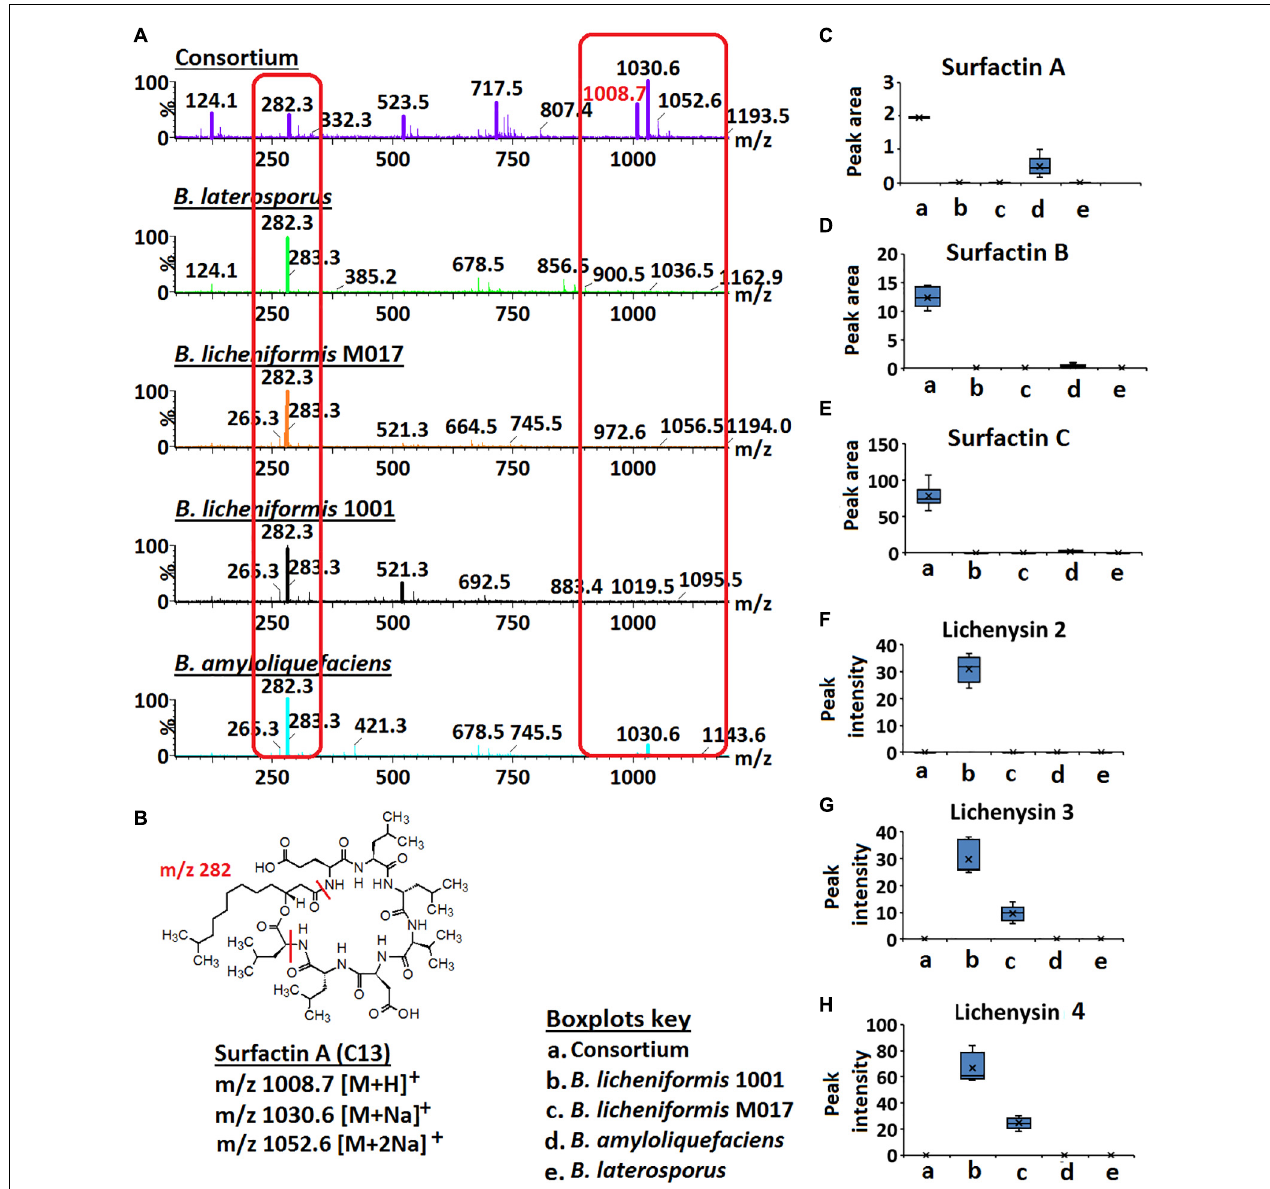
FIGURE 4 | Full MS scans of m/z 1008.7/1030.6 (surfactin A) and relative quantification of surfactins and lichenysins. (A) Full MS scans of m/z 1008.7/1030.6 (surfactin A) in Bacillus consortium and Bacillus isolates, B. amyloliquefaciens , B. licheniformis 1001, B. licheniformis M017, and B. laterosporus . Increased ion intensity of m/z 1008.7/1030.6 is observed in the consortium whereas its fragment (m/z 282.3) is decreased (highlighted in red boxes). (B) Structure of surfactin A. (C–H) Boxplots showing the relative quantification of surfactins A–C and lichenysins 2, 3, and 4 in the Bacillus strains and the